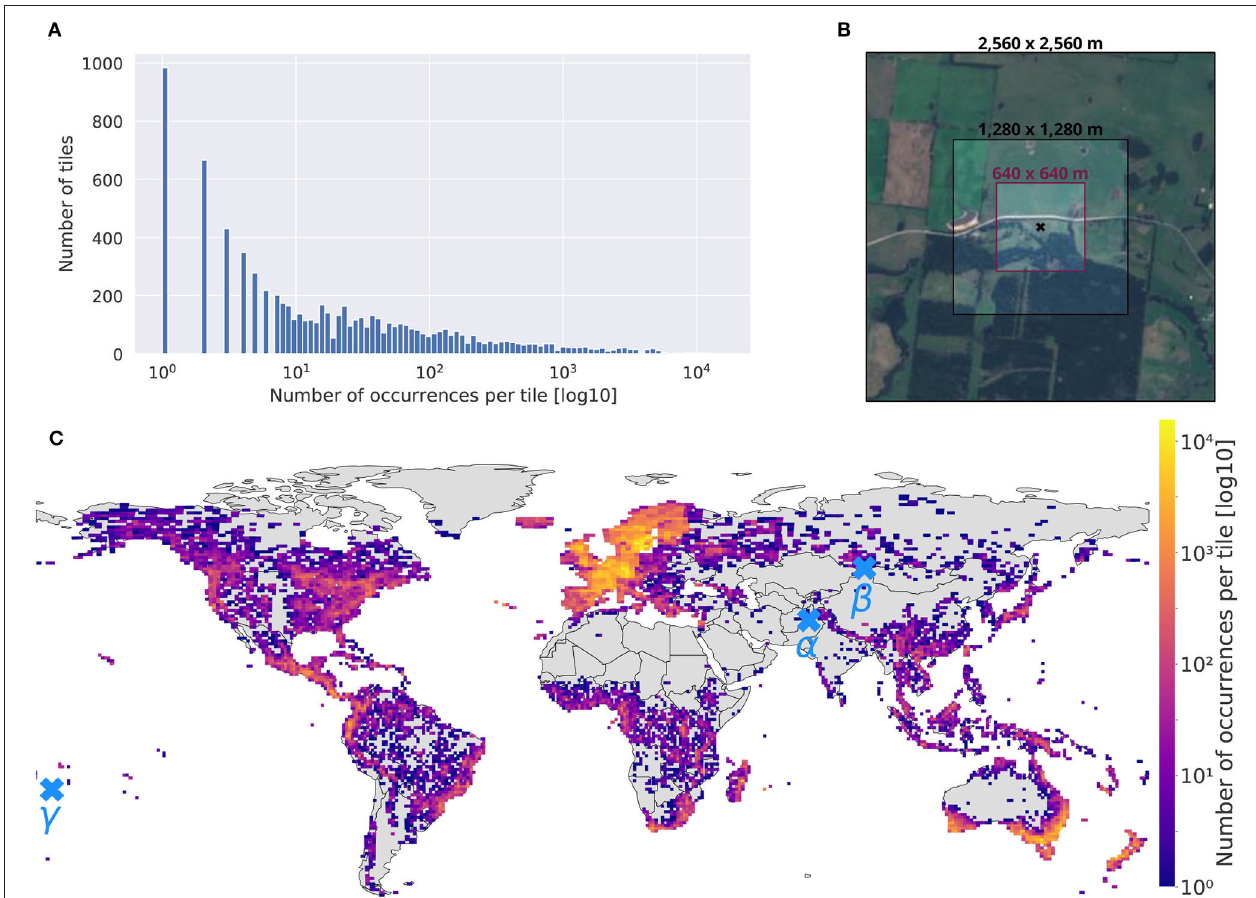
FIGURE 4 | (A) Histogram of the number of occurrences per tile, (B) different patch sizes comparison around an occurrence located at (–39.883306, 144.050000), decimal degree system, (C) map of the selected tiles colored by the number of records contained (log10 scale). Three occurrences are located by α , β , and γ . Figure 5 provides the three associated image